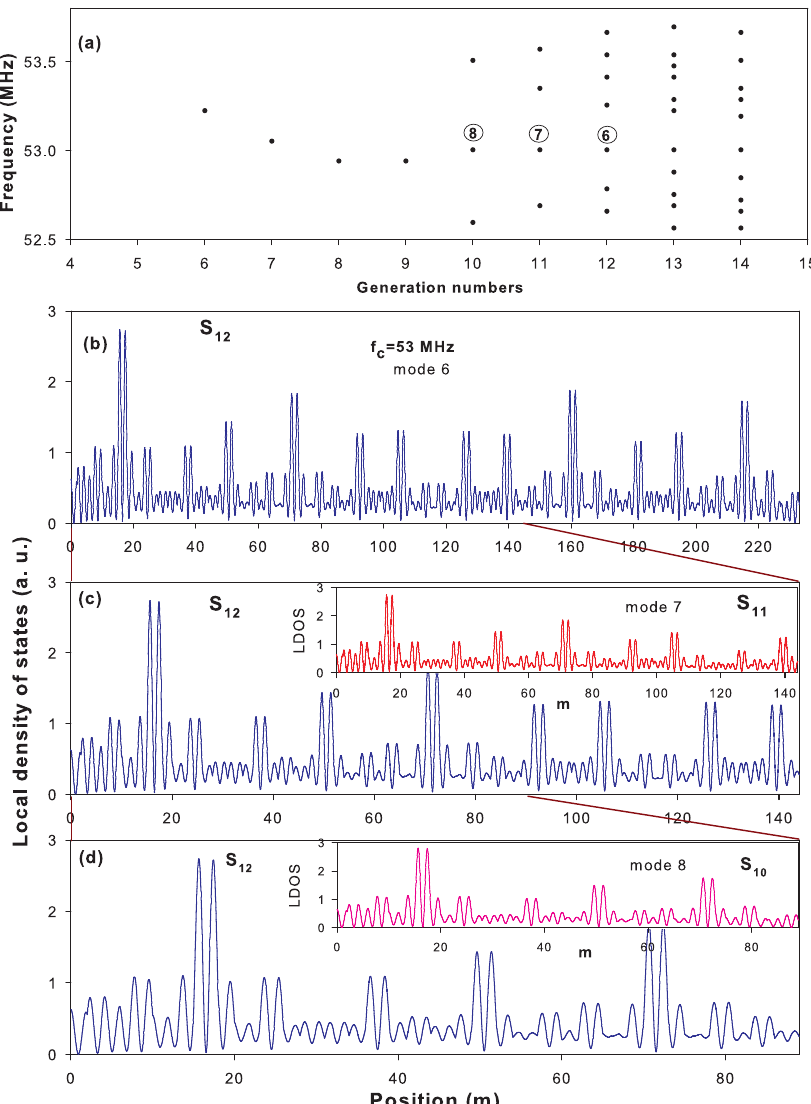
Figure 9. ( a ) Magnification of the FS modes around the central frequency f c = 53 MHz from Figure 7. ( b – d ) The LDOS (in arbitrary units) as a function of the space position x at the central frequency f c for the 12th generation (mode 6) where the range on the horizontal axis is adapted for comparison to 11th and 10th FS generations. The insets of ( c , d ) correspond to the LDOS associated with modes 7 and 8 for the 11th and 10th generations at f c ,